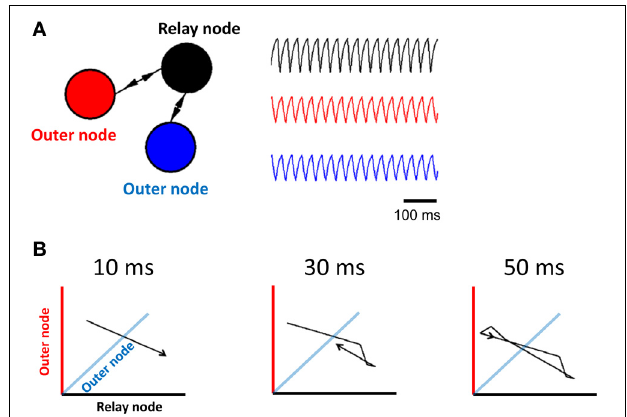
FIGURE 1 | Limit cycle activity in a simplified relay network. (A) Illustration of a relay network, where each node is modeled by a Wilson–Cowan equation (left panel), and generates periodic activity over time (right panel). The relay node sends/receives activation to/from the two outer nodes. (B) 3D phase-plane plots show activity at all three nodes of the Wilson–Cowan model (axis color is associated with the corresponding population). Each plot represents activity over a short timeframe. Once the trajectory has completed a full cycle (at 50ms), it loops back onto itself and repeats the